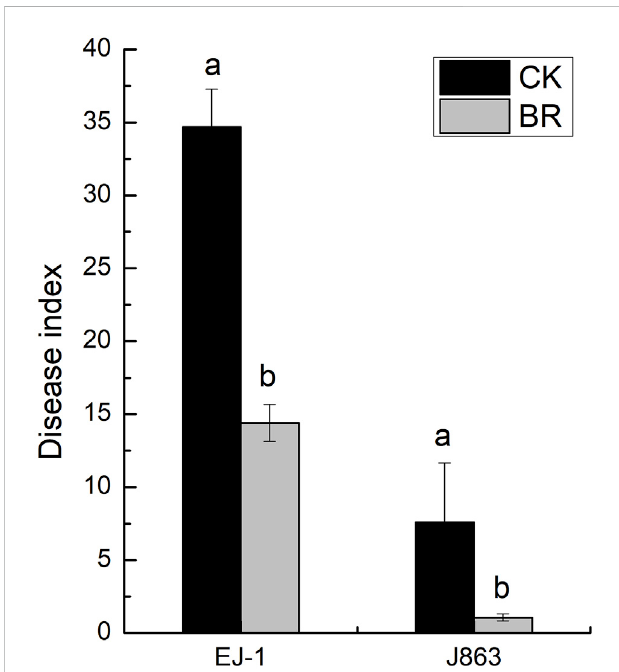
FIGURE 1 Comparison of the incidence of verticillium wilt of different cotton cultivars. CK represents treatment with blank control, BR represents treatmentwithbroccoliresidues.EJ-1representssusceptiblecultivarfor CVW, J863 represents resistant cultivar for CVW. Values are the means of three replicates. Means with the same letters for the same cultivar are not signi fi cantly different according to Student ’ s t-test at p < 0.05.